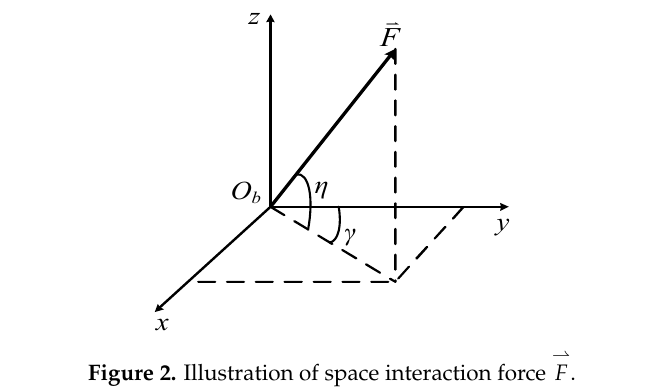
Figure 2. Illustration of space interaction force F